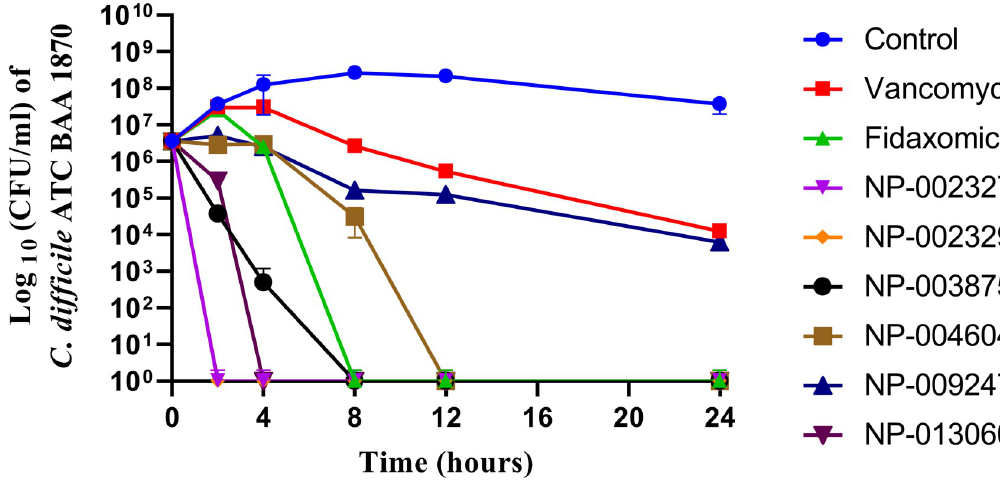
Fig 2. Killing kinetics of hit natural products, vancomycin, and fidaxomicin (5X MIC) against C . difficile . The standard deviation values for the triplicate samples of each natural product/control antibiotic have been represented by error bars.